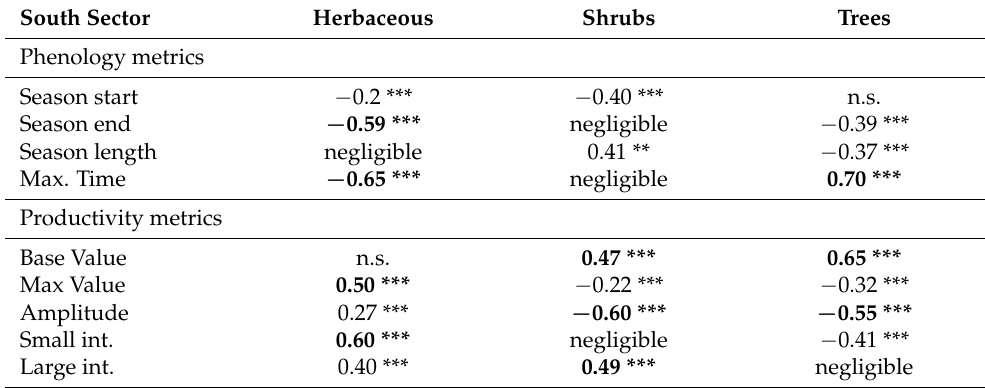
Table 4. Effect sizes (Cliff’s delta values, d) and Wilcoxon Signed-Rank test results of the changes in phenology and productivity metrics between the two time periods in the south sector. A positive delta value is associated with delay in time, an increase in productivity metrics or in season length in the second time period (and vice-versa for negative values, see text). Wilcoxon Signed-Rank test p -values: ** p < 0.01, *** p < 0.001, n.s.: p > 0.05. Effect sizes are considered negligible if |d| < 0.147 and large (in bold) if |d| > 0.473.